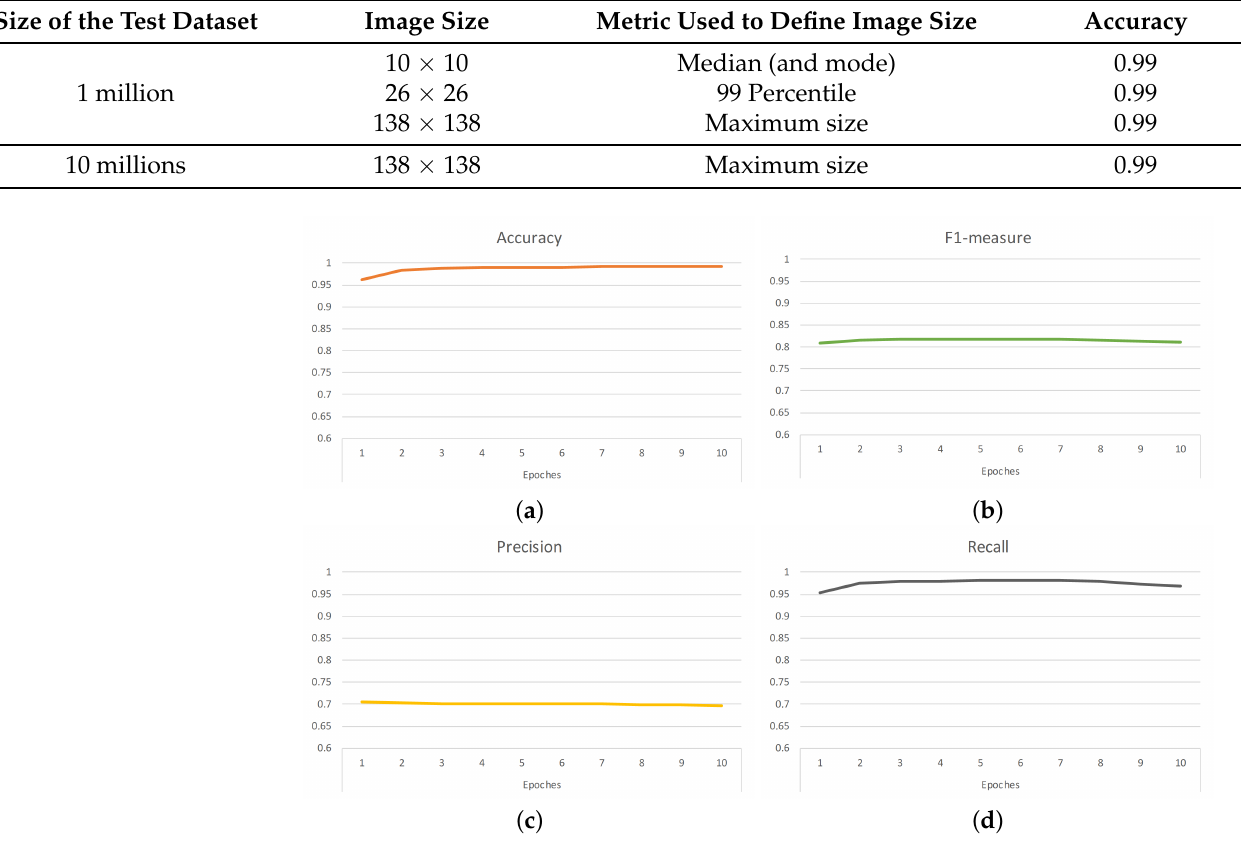
Figure 6. Parameters of the CNN training on the dataset consisting of 10 millions of